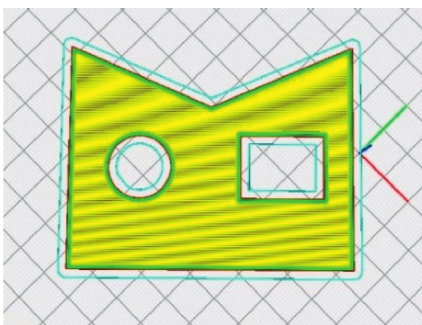
Figure 9: Offset line of model contour.